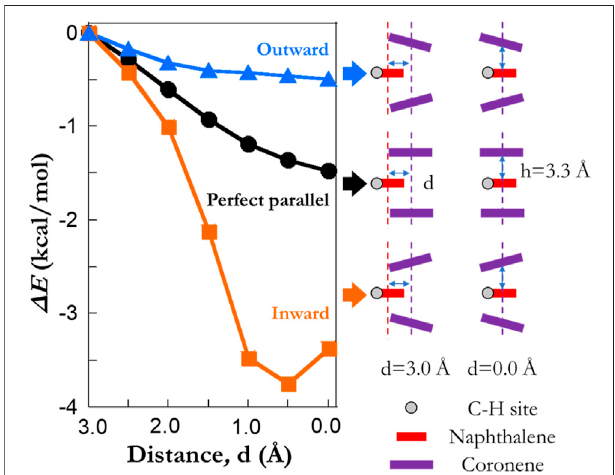
FIGURE 5 | Fitted gaussian distribution of barrier heights for hydrogen abstractions by H radicals including NAP 10 , NAP 15 , PYR 5 , PYR 10 , COR 5 and COR 10 clusters. A correction of 2.5 kcal/mol is included to account for the errorsinthefrozenalgorithm. μ and σ representsthemeanandstandard deviation of the fi tted distributions.